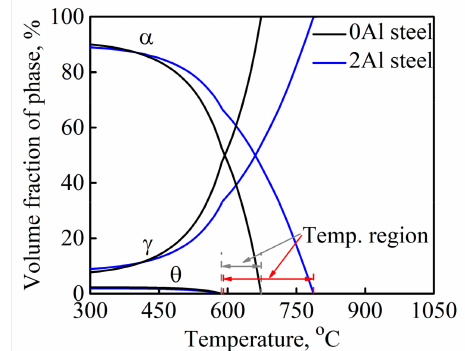
Figure 1. The equilibrium volume fraction obtained from Thermo-Calc of 0Al steel and 2Al steel. α : ferrite, γ : austenite, θ : cementite, Temp. region: annealing temperature region for 0Al steel and